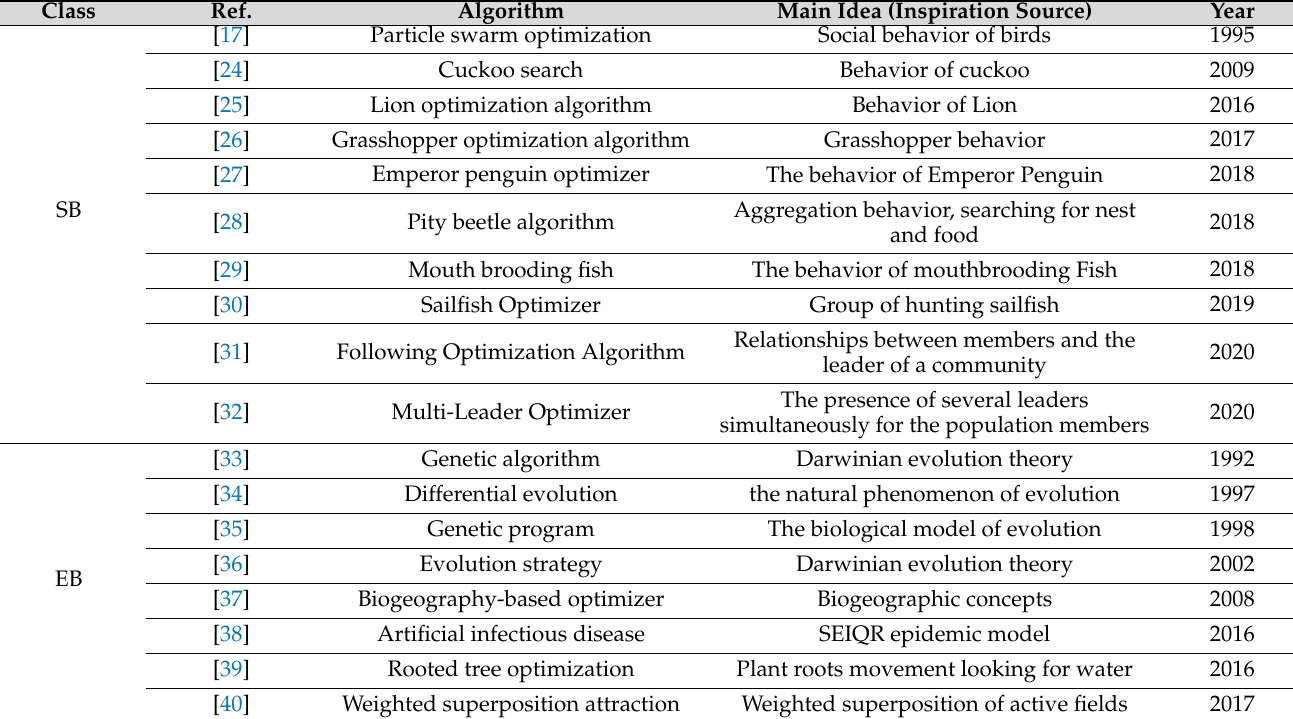
Table 1. Well-known meta-heuristic algorithms (MHAs) are proposed in the literature. Class Ref.